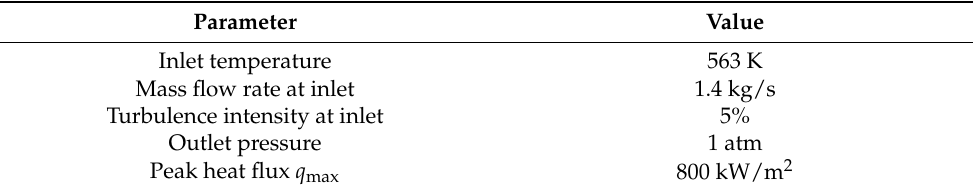
Table 2. Thermal properties of the molten salt and stainless steel.